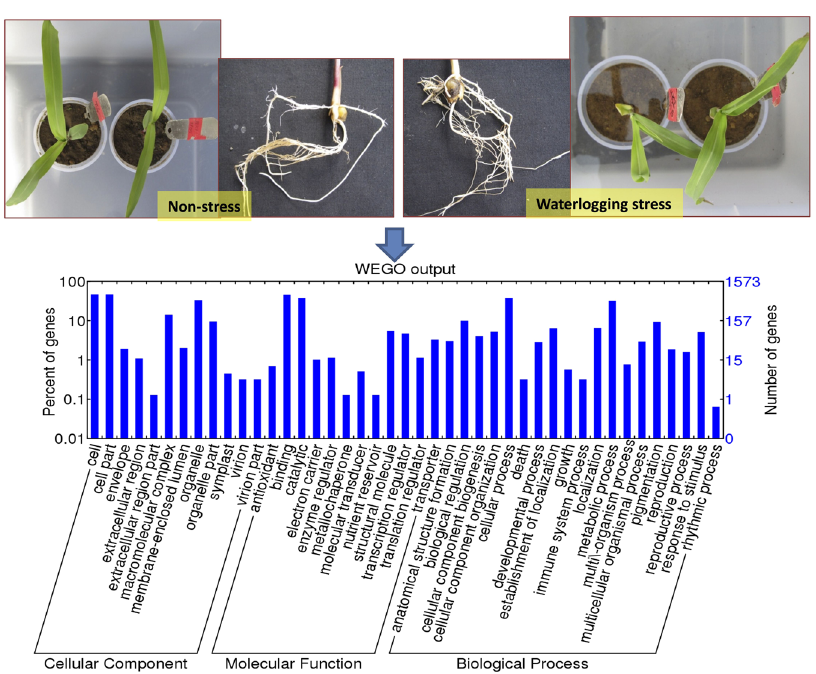
Figure 1. Representation of differentially expressed genes during waterlogging stress in selected Gene ontology (GO) categories in maize. Differentially expressed genes were annotated according to GO categories cellular component, molecular function, and biological process. Number of genes represent the differentially expressed genes in waterlogging tolerant genotype HKI 1105.